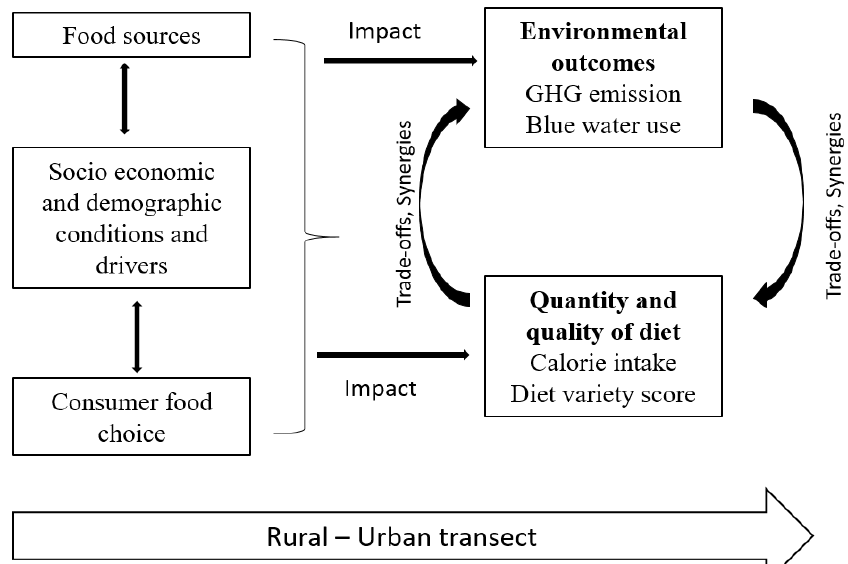
Figure 2. Flow chart of all components and the conceptual framework of the study. Adopted by authors from [29].